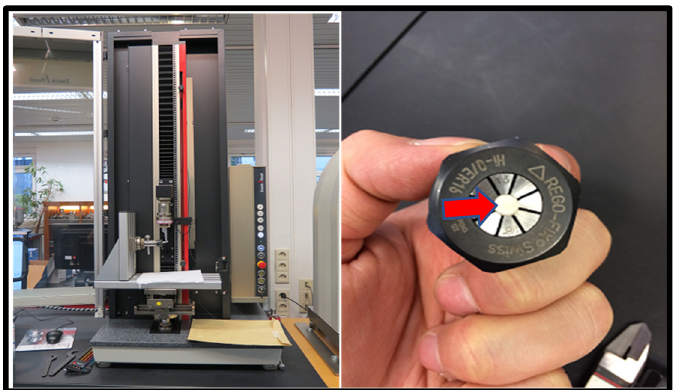
Figure 3. Universal Testing Machine ( left ), spiral grip device with a sample in the center (( right ), indicated by red arrow).